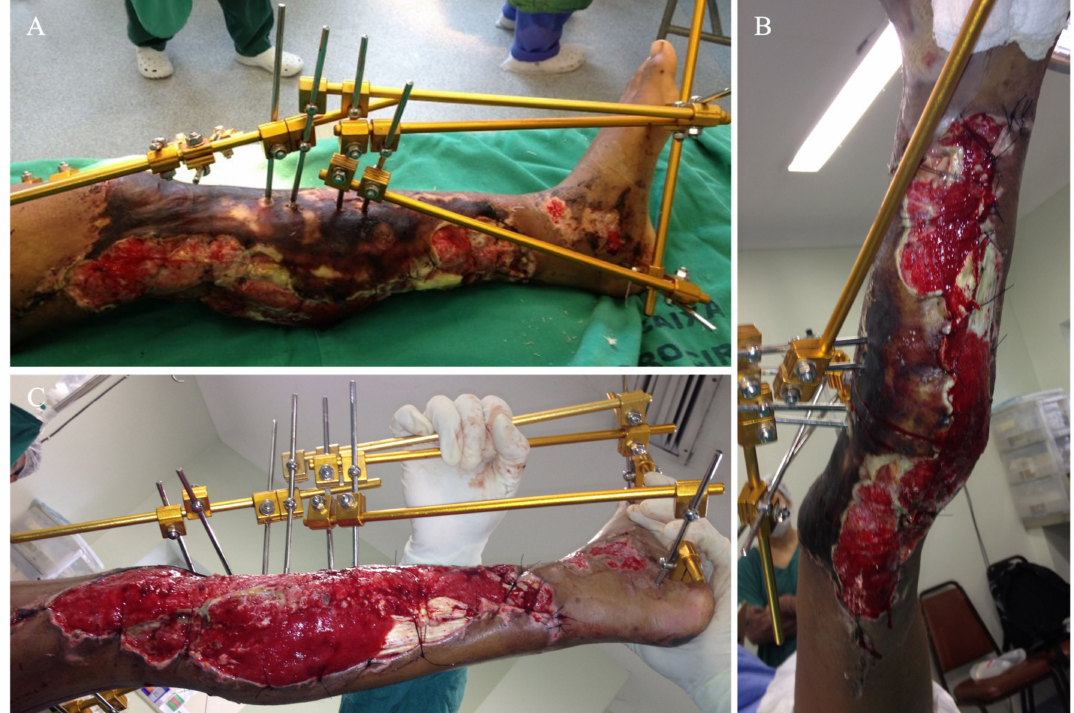
Figure 3. ( A , B ) Anterior and medial aspects of the left leg on day 2, demonstrating a large area of necrosis in the antero- medial part of the left leg. ( C ) The skin flap used to cover the degloved area of the leg was completely removed, and the wound was extensively debrided and irrigated.